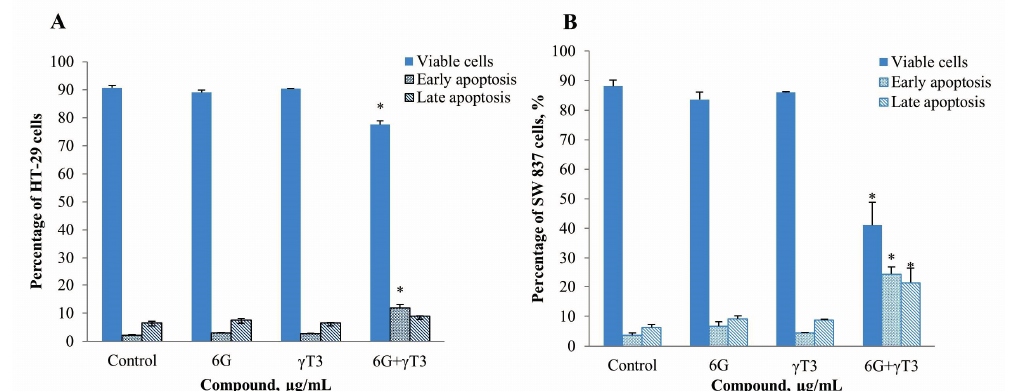
Figure 7. Annexin V FITC analysis on control, sub-lethal concentration of individual 6G and γ -T3, and combined 6G+ γ -T3 treatment on both ( A ) HT-29 and ( B ) SW837 cells. The number of cells decreased ( p < 0.05) in 6G+ γ -T3 treatment as compared to control, both in HT-29 and SW837 cells. No significant difference was observed between individual treatment of 6G and γ -T3 when compared to control cells. Percentage of viable, early and late apoptotic cells. Data are presented as mean ± SEM of three independent experiments. * p < 0.05 vs.